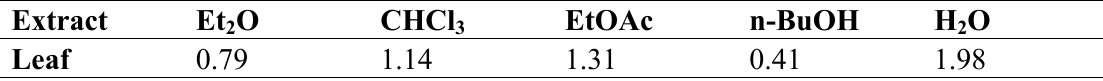
 and NO radicals with M. 2